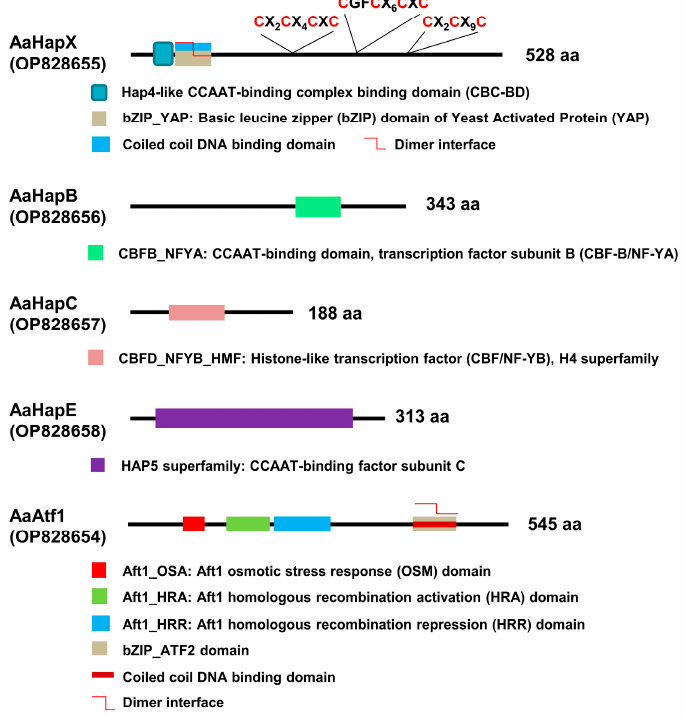
Figure 1. Schematics showing the functional domains of five transcription regulators associated with siderophore production in A. alternata . Both AaHapX and AaAtf1 are bZIP-containing transcription factors. Three cysteine-rich regions conserved in the AaHapX are also indicated. AaHapB, AaHapC, and AaHapE are CCAAT-binding